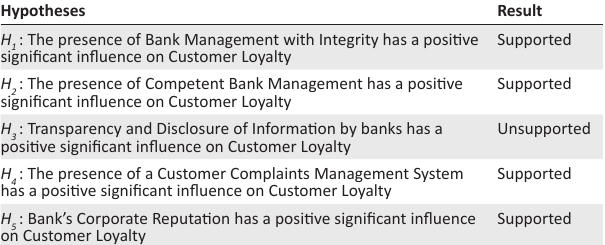
TABLE 9: Summary of test of hypotheses.